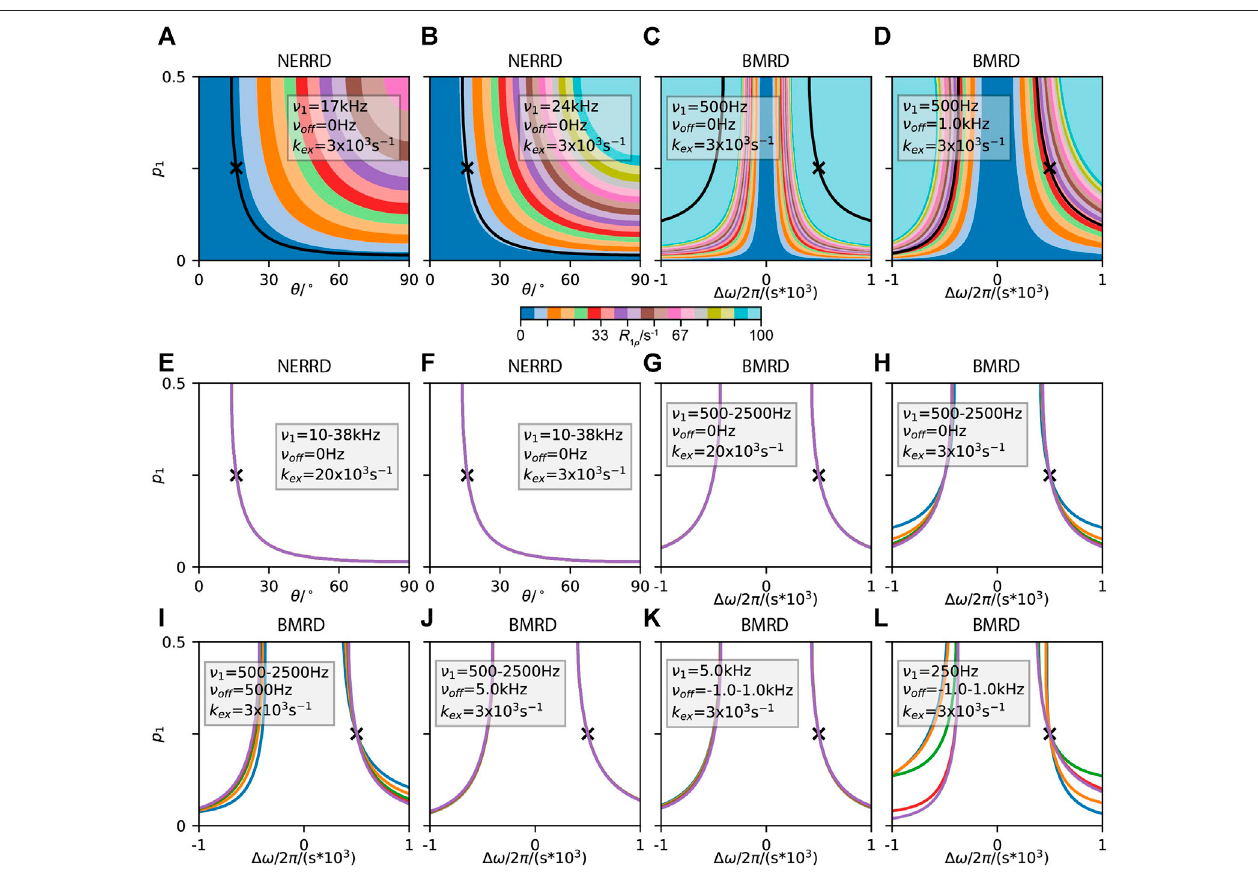
FIGURE 12 | Separating population from hop angle and change in chemical shift in NERRD and BMRD experiments. Relevant parameters are shown as insets ( ω r /2 π (cid:2) 40 kHz for NERDD plots). In (A – D) , contour plots are shown for NERDD and BMRD relaxation rate constants under various conditions, and in each plot, a contourshowsallvaluesof p 1 and θ or Δ ω 1 thatyield R 1 ρ equaltothevalueobtainedfor p 1 (cid:2) 0.25and θ (cid:2) 16 ° or Δ ω I (cid:2) 500 Hz(markedasacrossoneachplot).In (E – L) , we only show the contour, but for a range of experimental conditions ( fi ve experiments, linearly spaced, with range indicated in the plot). In some cases, this yields nearly identical contours, such that we only see one of the fi ve